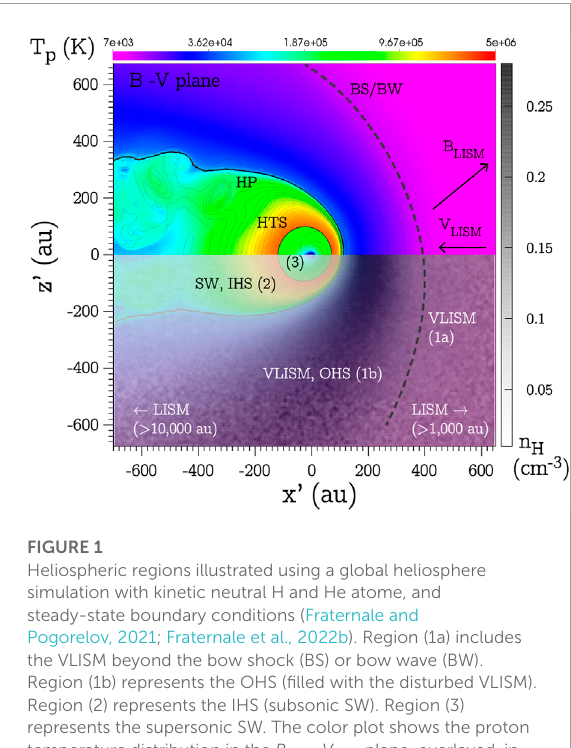
FIGURE 1 Heliospheric regions illustrated using a global heliosphere simulation with kinetic neutral H and He atome, and steady-state boundary conditions (Fraternale and Pogorelov, 2021; Fraternale et al., 2022b). Region (1a) includes the VLISM beyond the bow shock (BS) or bow wave (BW). Region (1b) represents the OHS (filled with the disturbed VLISM). Region (2) represents the IHS (subsonic SW). Region (3) represents the supersonic SW. The color plot shows the proton temperature distribution in the B LISM - V LISM plane, overlayed, in the bottom half, to the neutral hydrogen density